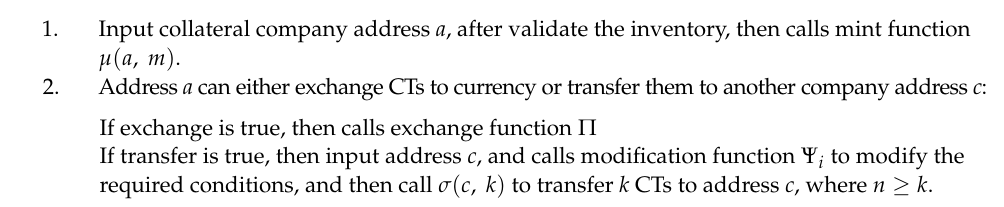
Algorithm 2 The processes and the operations of inventory financing